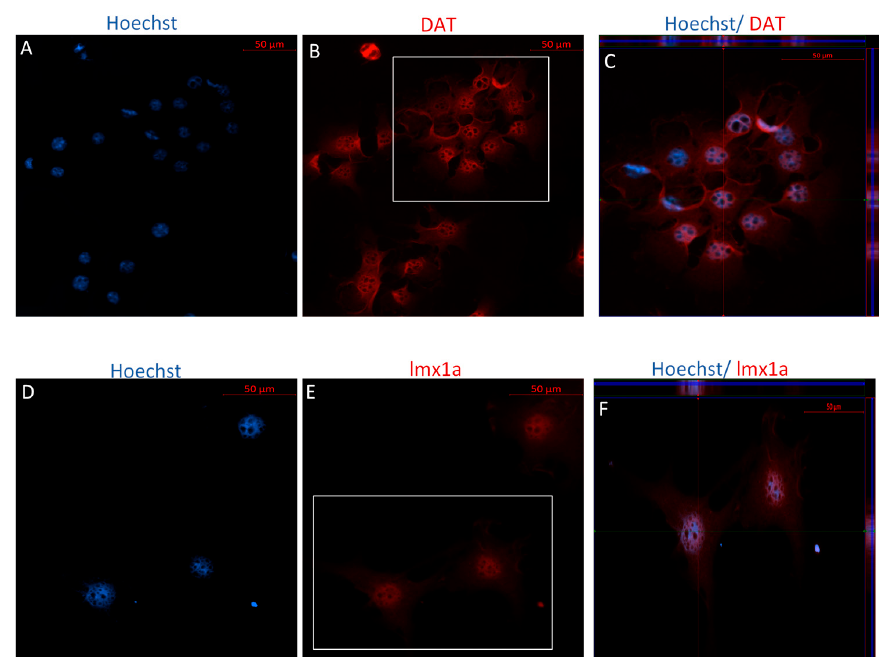
Figure 8. Immunocytochemistry/immunofluorescence (ICC/IF) performed on P4 MSCs following Stage Two of the IDI. Hoechst-labeled P4 MSCs ( A , D ) revealed positive staining of the mature dopaminergic marker, DAT (( B ) red), and the immature dopaminergic marker, LMX1a (( E ) red), following exposure to SHH, FGF-8, bFGF, and BDNF. There was no bright staining detected for TH for P4 differentiated cells (image not included). Orthogonal displays of z -stacks are represented in merged images ( C , F ).